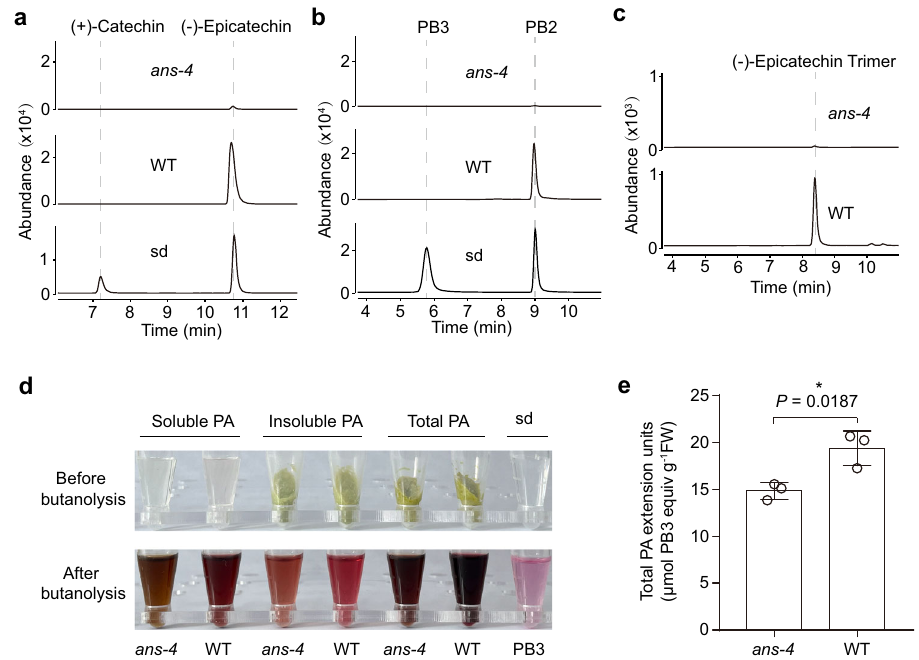
Fig. 2 PA composition analysis in 7 DAP siliques of the A. thaliana ans-4 mutant. a – c HPLC-QqQ chromatograms for characterization of the soluble PA fraction in 7 DAP siliques of the A. thaliana ans-4 mutant and wild-type (WT) plants. a MRM transition of m/z (289 → 123) showing that trace amounts of ( − )-epicatechin remained in the ans-4 mutant. b MRM transition of m/z (577 → 407) showing that the ans-4 mutant has lost B-type procyanidin dimer. c MRM transition of m/z (865 → 407) showing that the ans-4 mutant has lost B-type procyanidin trimer. d Visualization of the presence of PA extension units in 7 DAP siliques of ans-4 mutant and WT by the butanolysis method. The upper panel shows the non-lyophilized soluble PA and the residues containing insoluble PA and total PA before applying butanolysis. Soluble PA was extracted with acetone/water followed by chloroform extraction to remove chlorophyll. Insoluble PA remained in the residues after soluble PA extraction. The residues containing total PA were obtained as the ground tissue only with chloroform extraction to remove chlorophyll. The lower panel shows the butanolysis supernatant of the lyophilized soluble PA and the residues containing insoluble PA and total PA after reaction. Procyanidin B3 (0.25 mM) standard (sd) served as the positive control. e Quanti fi cation of total PA extension units in 7 DAP siliques of ans-4 mutant and WT. PA extension levels were determined by the butanol-HCl method and expressed as procyanidin B3 (PB3) equivalents. FW: fresh weight. Data are shown as the mean ± SD (for n = 3 biologically independent samples; * P < 0.05, two-tailed unpaired Student ’ s t tests). Source data of Fig. 2e are provided as a Source Data fi